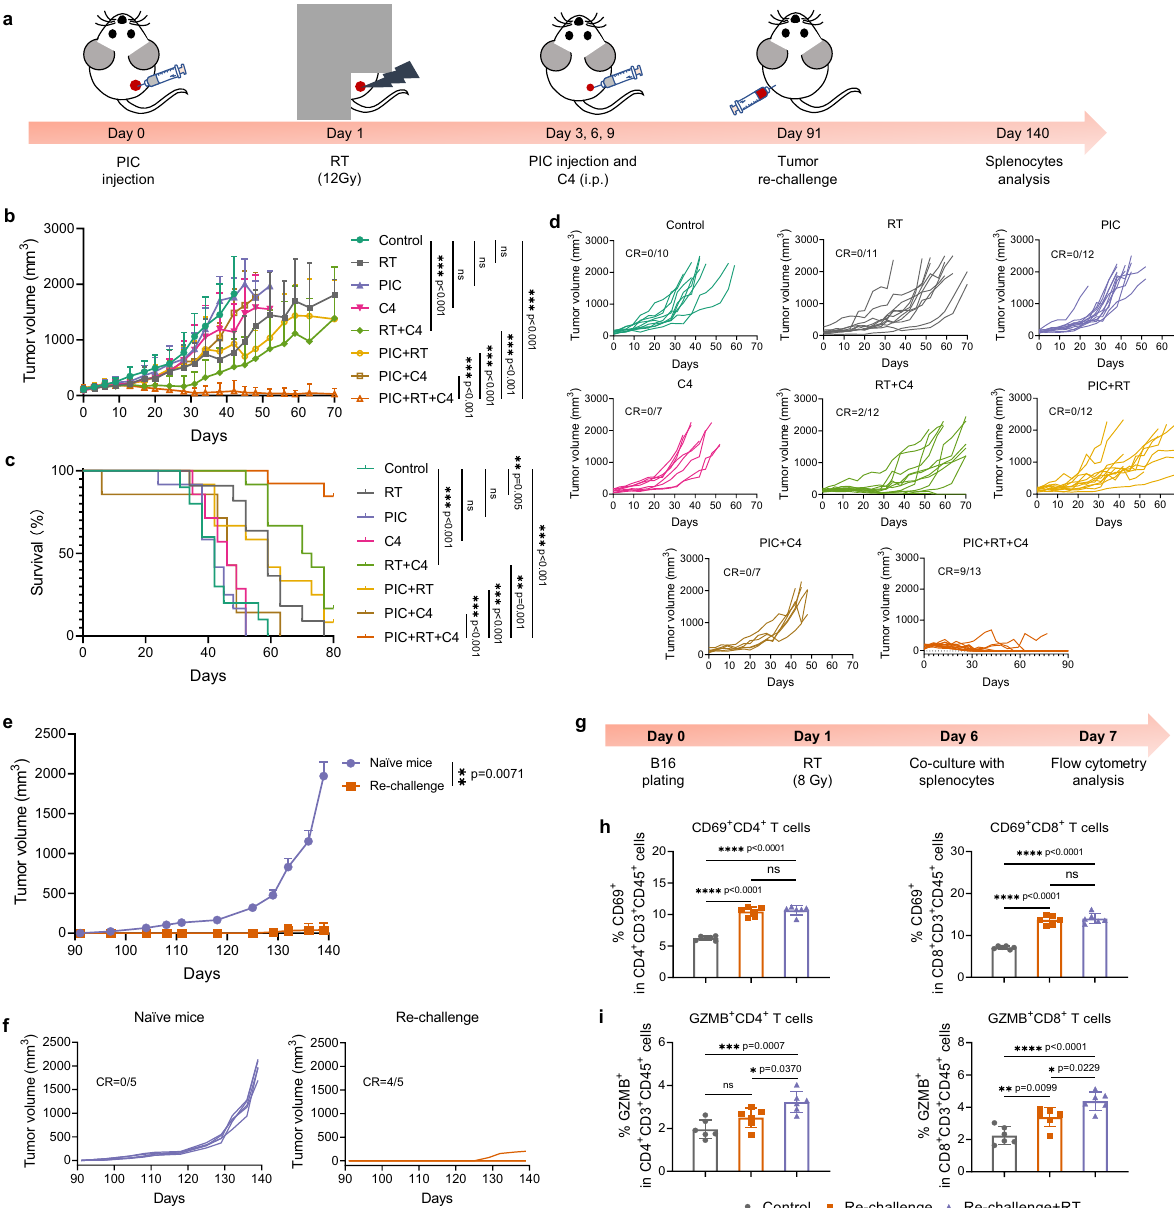
CD8 + T cells in splenocytes by fl ow cytometry. ( n =6 biologically independent samples). Control: non-radiated B16 cells co-cultured with splenocytes from naïve mice; Re-challenge: non-radiated B16 cells co-cultured with splenocytes from re- data are provided in Source Data fi